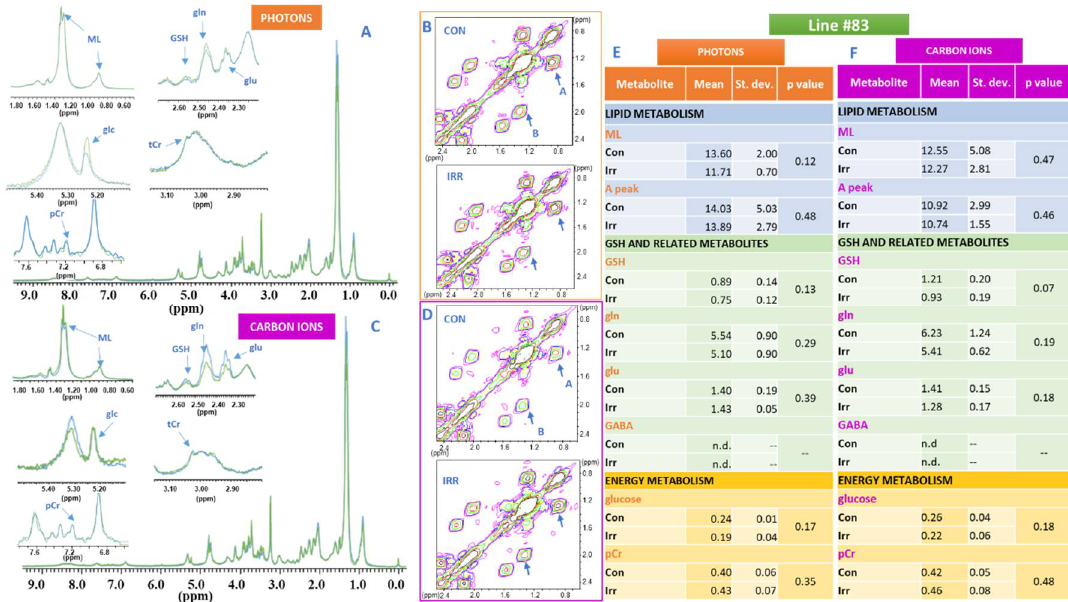
Figure 3. 1 H NMR spectra of line #83 cells, signals of interest and metabolic modifications induced by radiation ( A , B ) 1D and 2D spectra of photon beam irradiated line #83 cell samples (green trace) and corresponding controls (blue trace) together with the spectral regions of interest for the analysis: Mobile Lipids (ML, 1.28 ppm), glutathione and related metabolites (GSH 2.55 ppm, glu 2.35 ppm, gln 2.45 ppm), glucose (glc 5.22 ppm), total creatine (tCr, 3.02 ppm) and phosphocreatine (pCr, 7.25 ppm). In panel B the cross peak A, arising from the correlation of CH 3 -terminal methyl group of Fatty Acid (FA) chains with the bulk of FA (excluding omega-3 FAs), at (0.89–1.28) ppm, and cross peak B, representing both mono and polyunsaturated FA at (2.02–1.28) are labelled. Cross peak diagnostic for GABA is barely detectable (not shown). ( C , D ) 1D and 2D spectra of carbon ions irradiated samples (green trace) at 20 Gy and corresponding controls (blue trace) of lines # 1 and # 83. Region of interest were expanded. All spectra were acquired 48 h after irradiation at a dose of 20 Gy with both photons and carbon ions. Assignments were performed as reported in [21]. Tables ( E ) (photon beams) and ( F ) (carbon ions) show mean values of all analyzed metabolites signal intensities, standard deviations and p values, calculated on at least 5 experiments performed 48 h after irradiation and corresponding controls. Stars indicate statistically significant variations ( p value < 0.05).